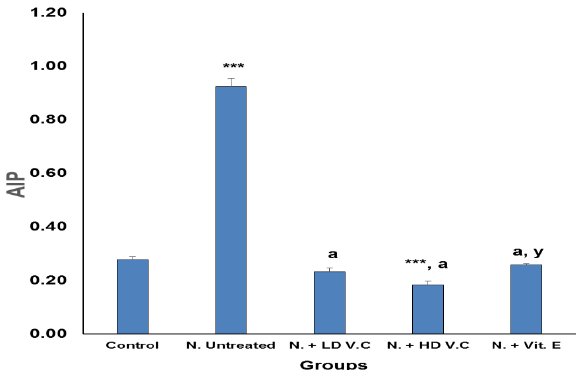
Figure 5. Effect of V. calvoana extract on the atherogenic index in paracetamol treated rats. Values are presented as mean ± SEM, n = 5. *** p < 0.001 vs. control, a = p < 0.001 vs. N. untreated, y = p < 0.01 vs. + HD V.C. Where N = hepatotoxic. N. + HD V.C. Where N =